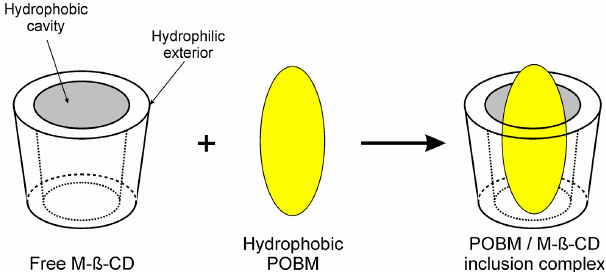
Figure 15. Schematic illustration of the association of free methyl- β -cyclodextrin and POBM to form a 1:1 inclusion complex. Reprinted from [32]. Copyright (2018), with permission from Elsevier.